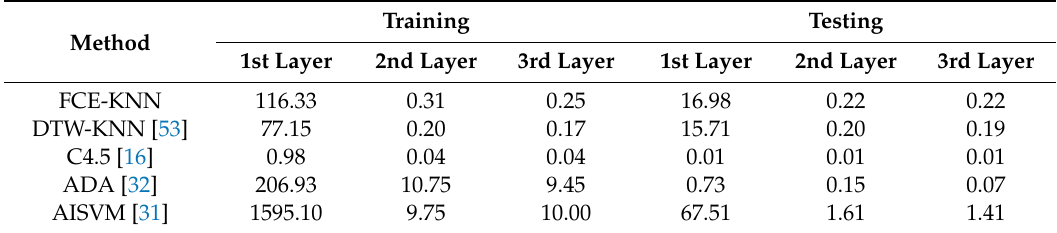
Table 10. Time consumption comparison between FCE-KNN and other algorithms in the framework of fine-grained classification